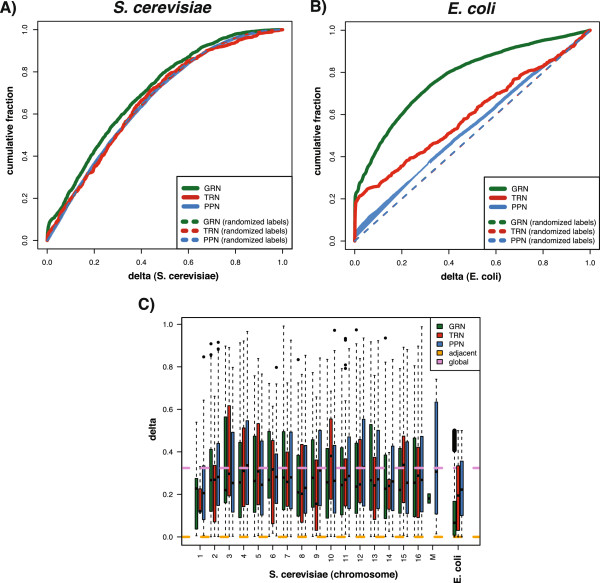
Cumulative distance distribution of gene pairs for the gene regulatory network (green), transcription regulatory network (red) and protein-protein network (blue). A:S. cerevisiae. B:E. coli. C:S. cerevisiae relative co-localization distance distribution for each chromosome of gene pairs for the gene regulatory network (GRN), transcription regulatory network (TRN) and protein-protein network (PPN).